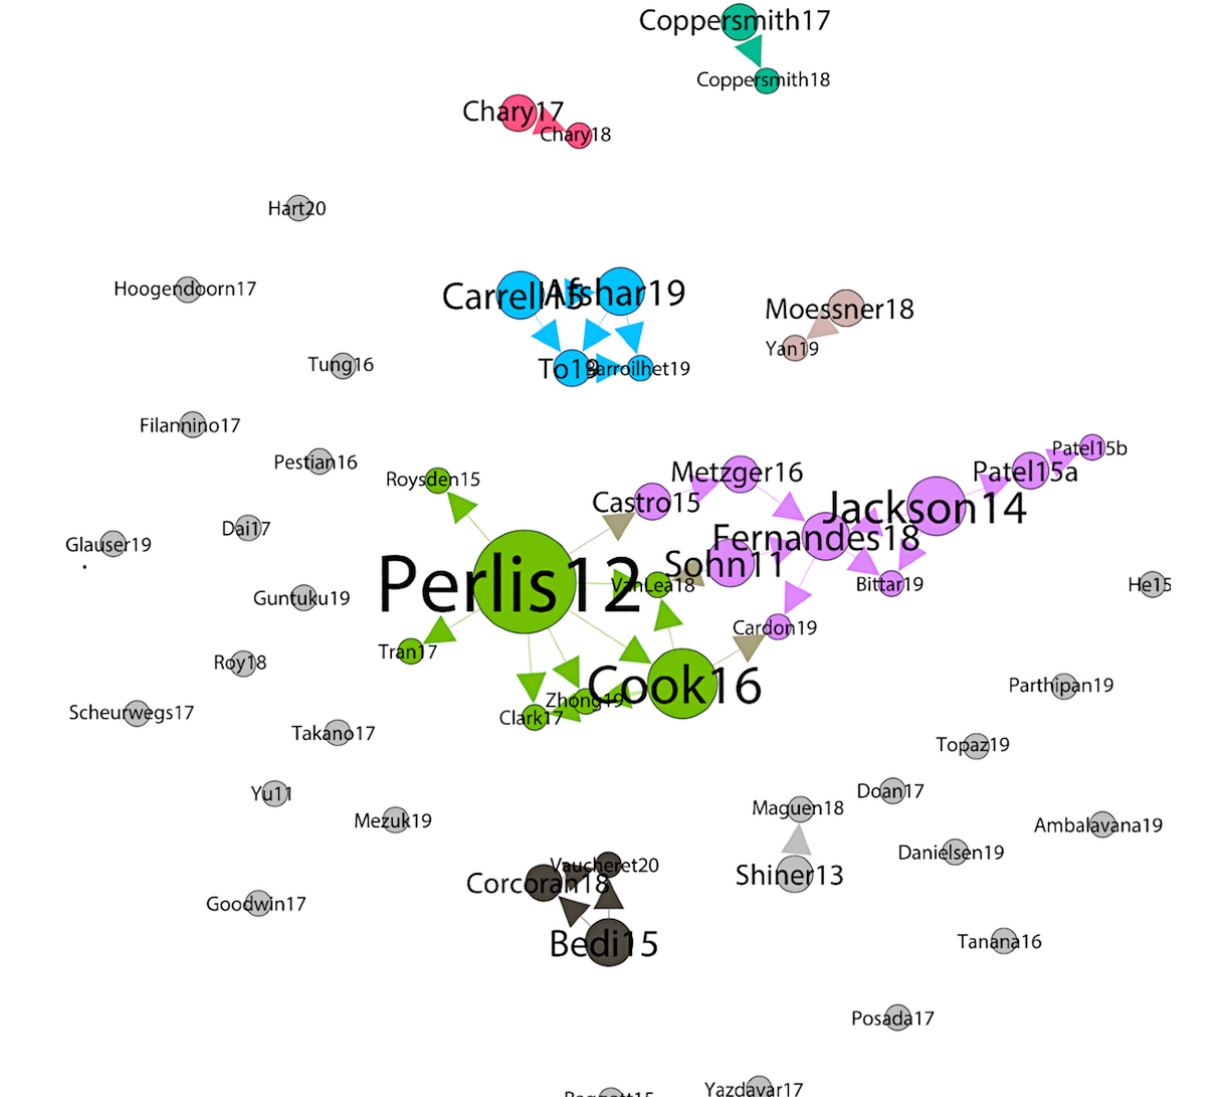
Figure 4. Graph of